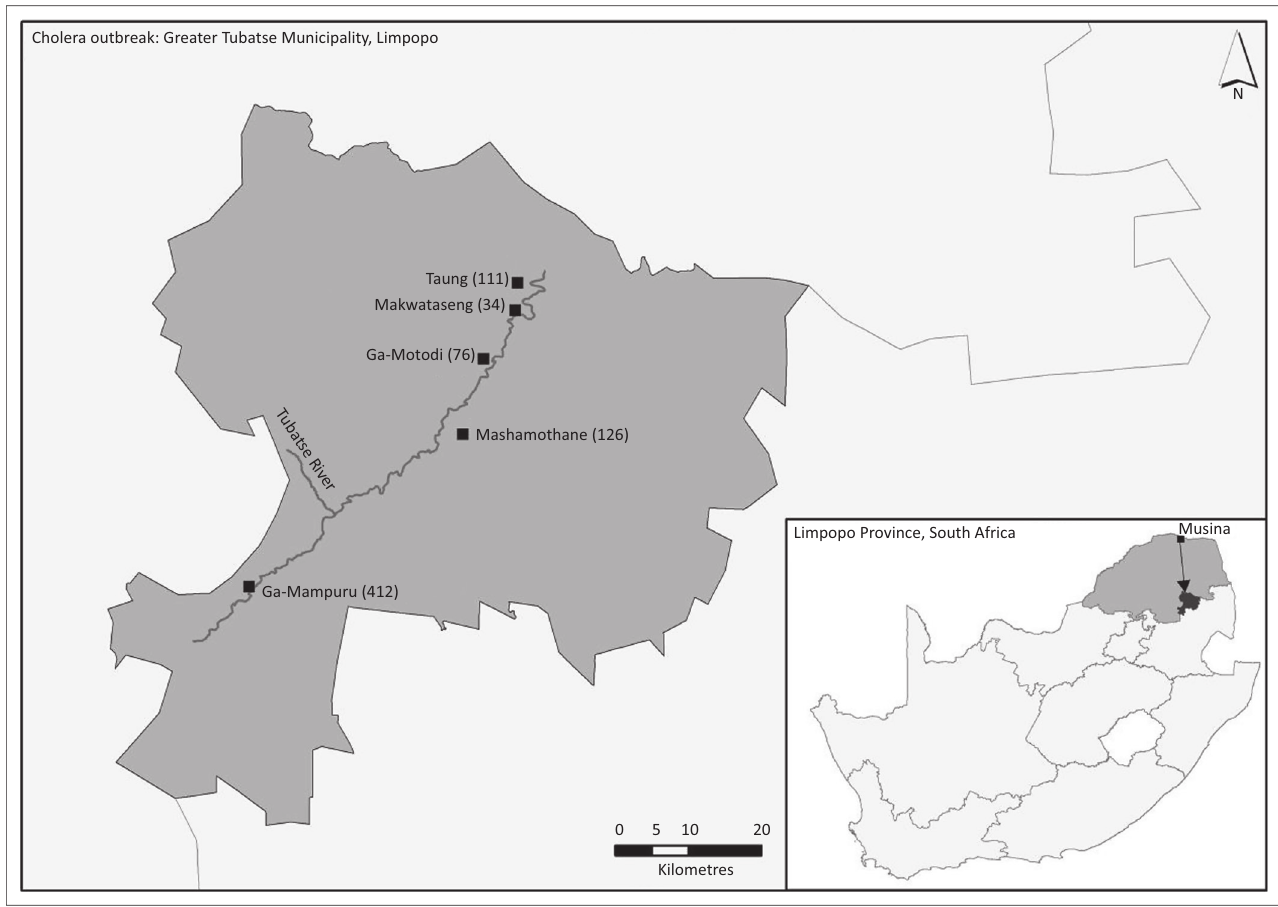
FIGURE 1: Cholera outbreak in the Greater Tubatse Municipality,